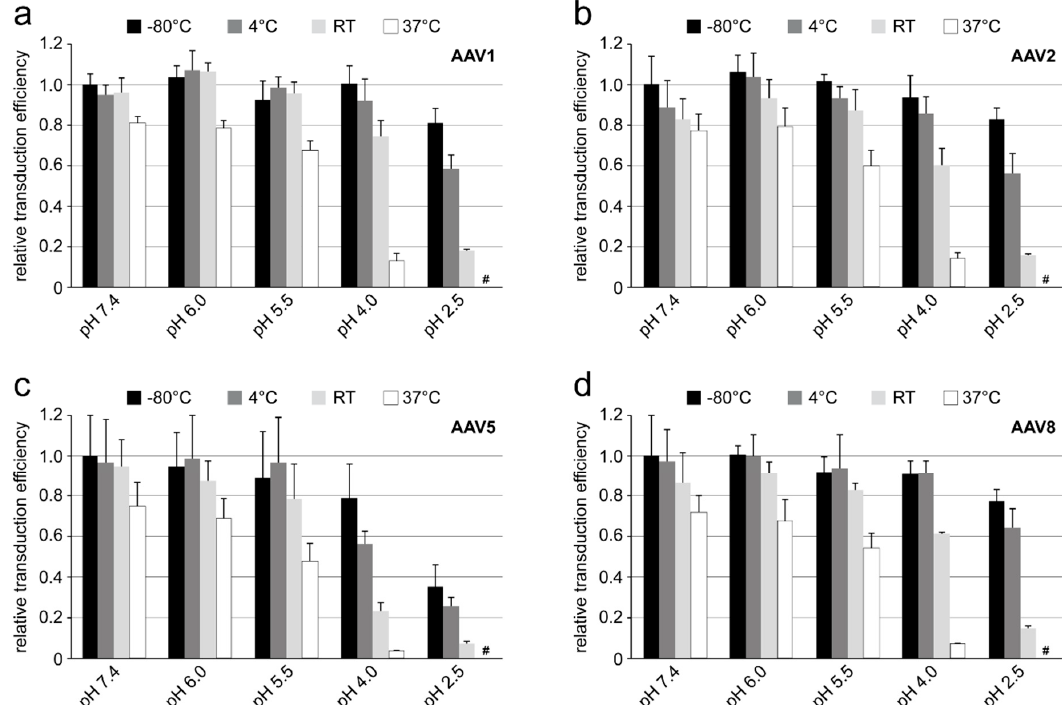
Figure 8. E ff ect of pH and temperature on AAV transduction. Transduction e ffi ciency of ( a ) rAAV1, ( b ) rAAV2, ( c ) rAAV5, and ( d ) rAAV8 (all packaging the luciferase gene) in HEK293 cells infected with virus incubated for 24 h in citrate-phosphate buffer at the indicated pH and storage temperature. The transduction efficiency for each AAV serotype is shown relative to virus stored at pH 7.4 and − 80 °C. The experiments were performed in triplicate and are displayed as mean+SD (n = 3). #: luciferase read-out similar to uninfected control cells (data not shown) which indicates no transduction.